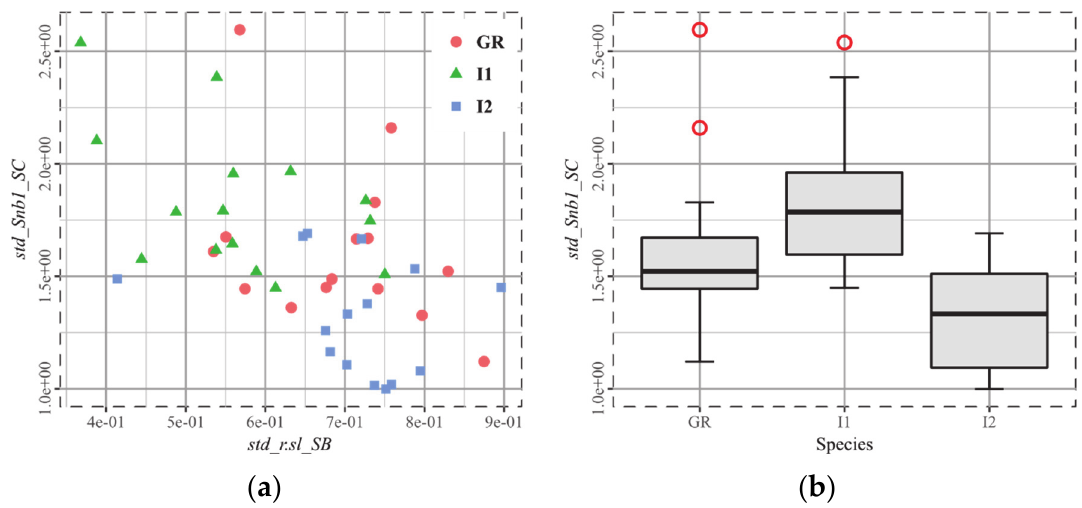
Figure 8 . Red deer I1 and I2, most discriminating parameters. ( a ) The anisotropy parameter r.sl together with the topology parameter Snb1 make it possible to separate them; and, ( b ) std_Snb1_SC is statistically lower for I2 than for I1. Technologies 2018 , 6 , x FOR PEER REVIEW